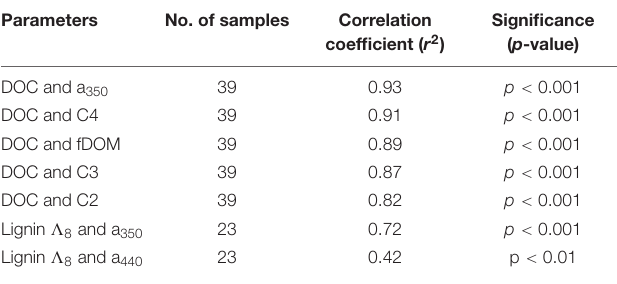
TABLE 3 | Optical parameter relationships to DOC concentration and lignin carbon normalized yield ( (cid:51) 8 ).